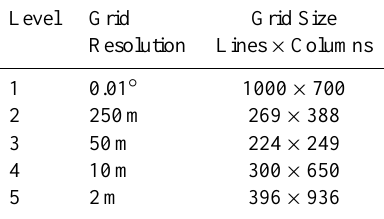
Table 2. Domain Resolution.